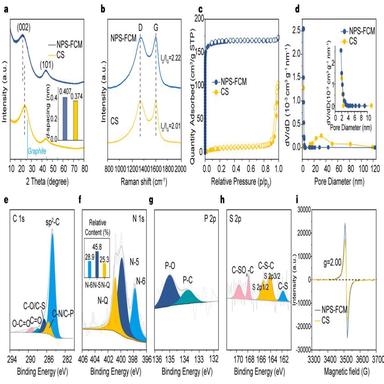
Structure and composition characterizations of NPS-FCM material. a) XRD pattern (insert: calculated d-spacing), (b) Raman spectra, (c) N2 adsorption–desorption isotherms, and (d) pore size distribution curves of NPS-FCM and CS materials. High-resolution XPS (e) C 1s, (f) N 1s, (g) P 2p, and (h) S 2p spectra of NPS-FCM material. (i) EPR test of NPS-FCM and CS materials.